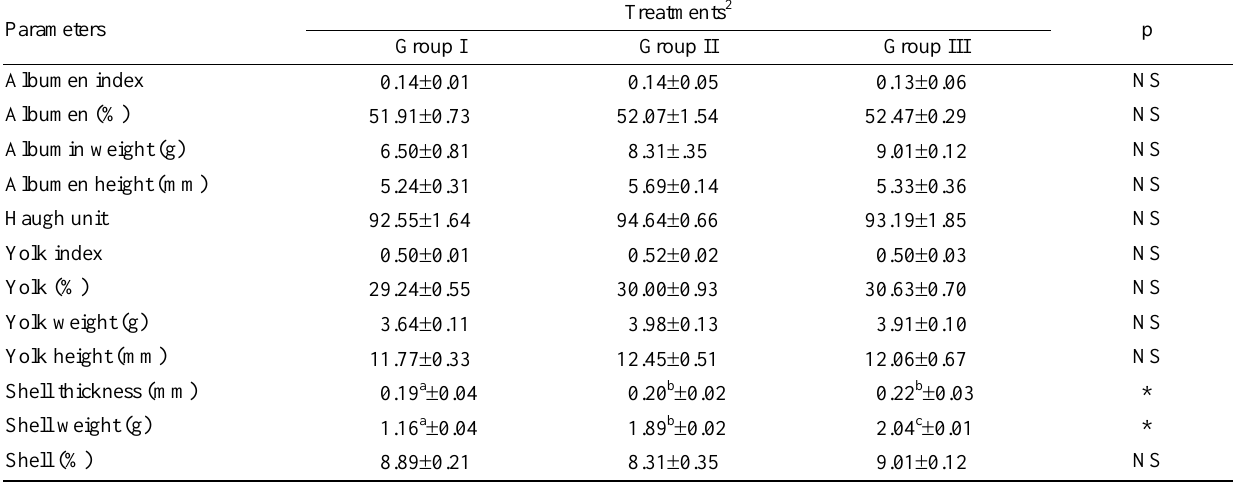
Table 4. The effect of different doses of dietary L-ascorbic acid (L-AA) supplementation on internal egg quality in laying Japanese quail under low ambient temperature (10.47  C) 1